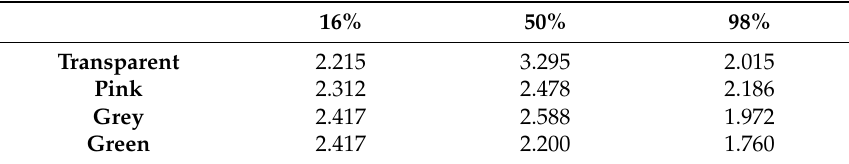
Table 4. Elongation of the samples according to their storage